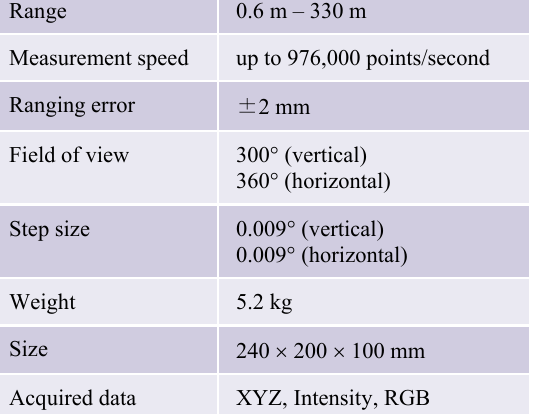
Figure 10. TLS observation plan